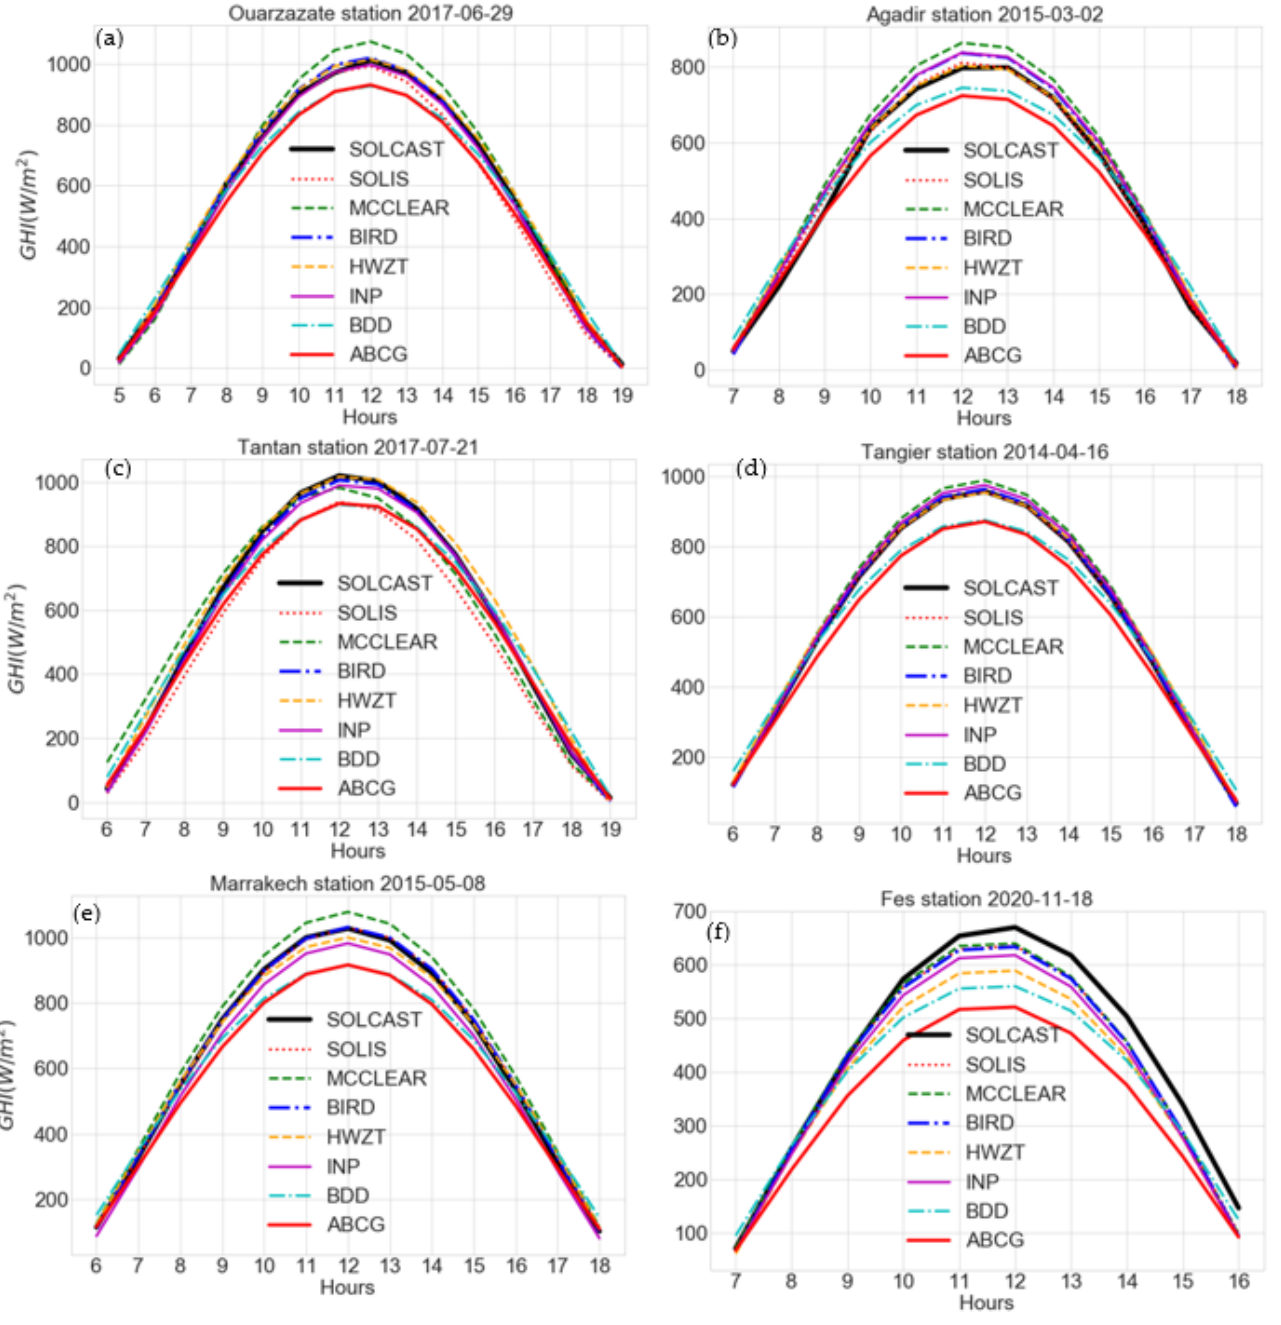
Figure 6 . Comparison between McClear and modelled clear sky hourly GHI values in Ouar- Figure 6. Comparison between McClear and modelled clear sky hourly GHI values in Ouarzazate ( a ), Agadir ( b ), Tantan ( c ), Tangier ( d ), Marrakech ( e ), and Fes ( f